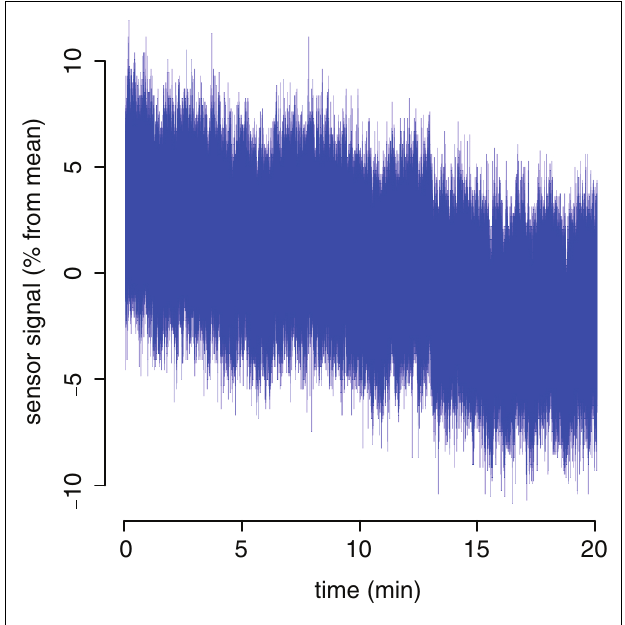
FIGURE 4 | Warm-up characteristics of the bend sensor